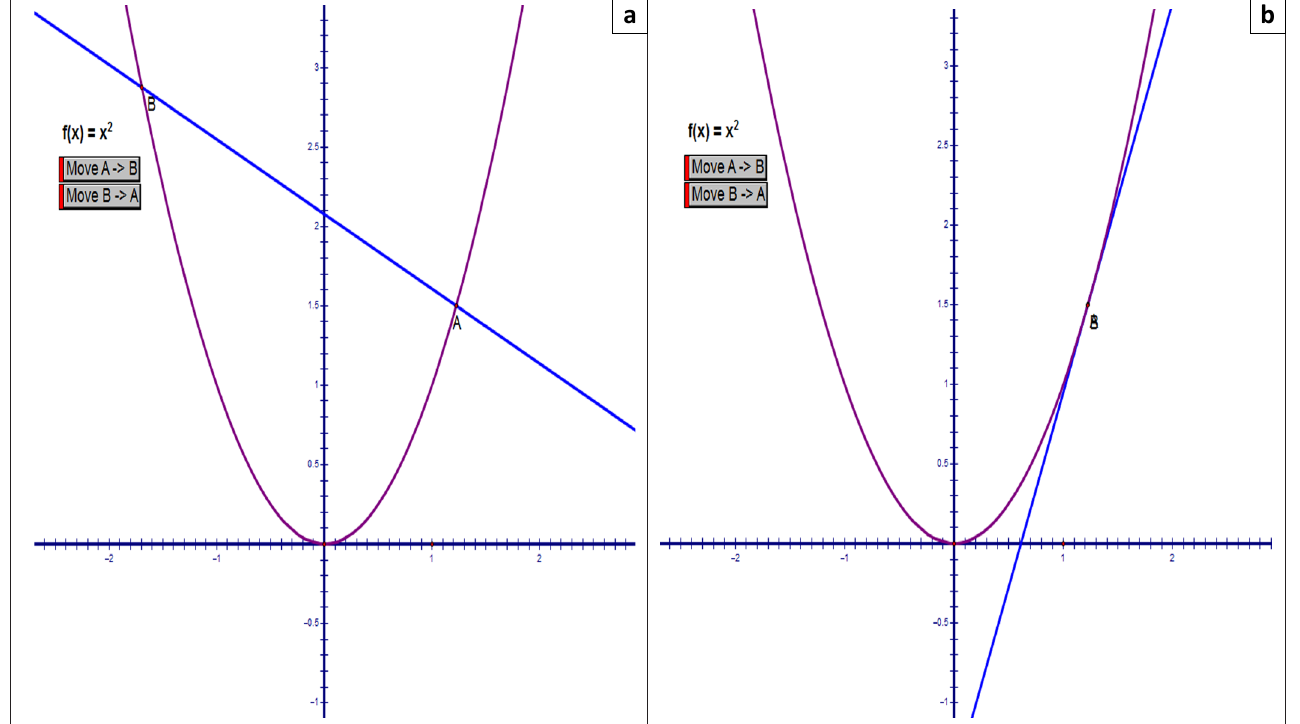
FIGURE 7: Construction of the tangent (a) before animation (b) after